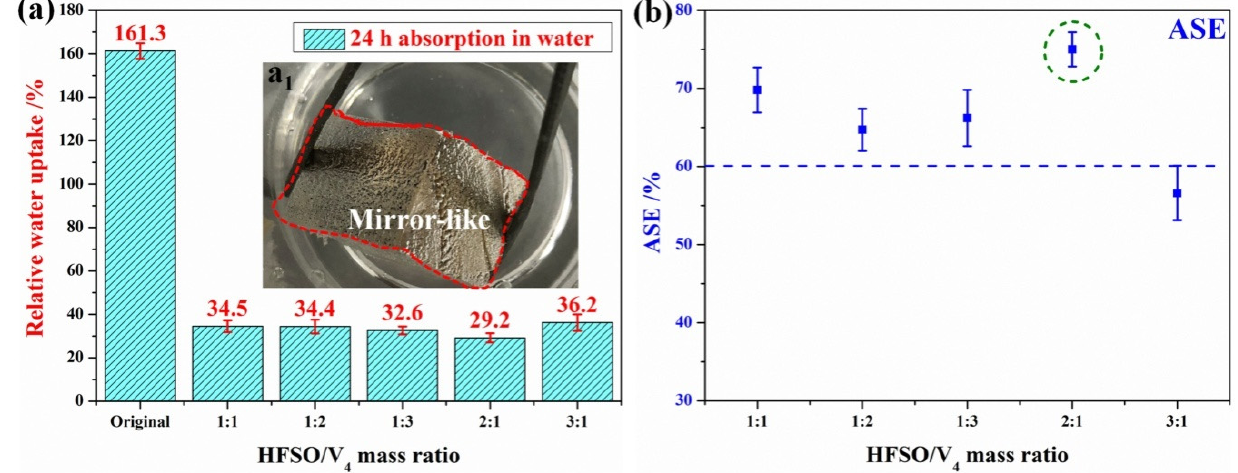
Figure 5. Test of water absorption ( a ) and anti-swell efficiency ( b ) of wood before and after modification after soaking in water for 24 h. ( a 1 ) image of wood soaked in water.